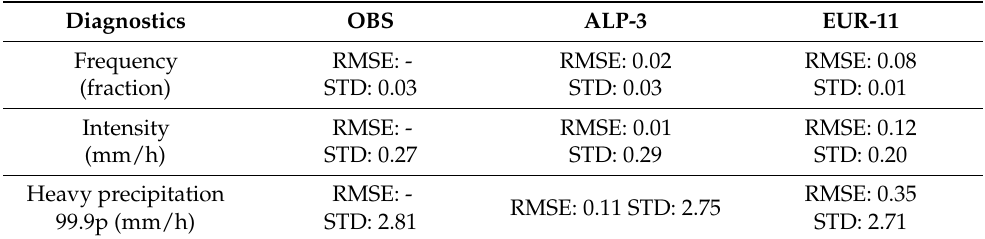
Table 5. RMSE and STD referred to the hourly statistical indicators in Figure 4.